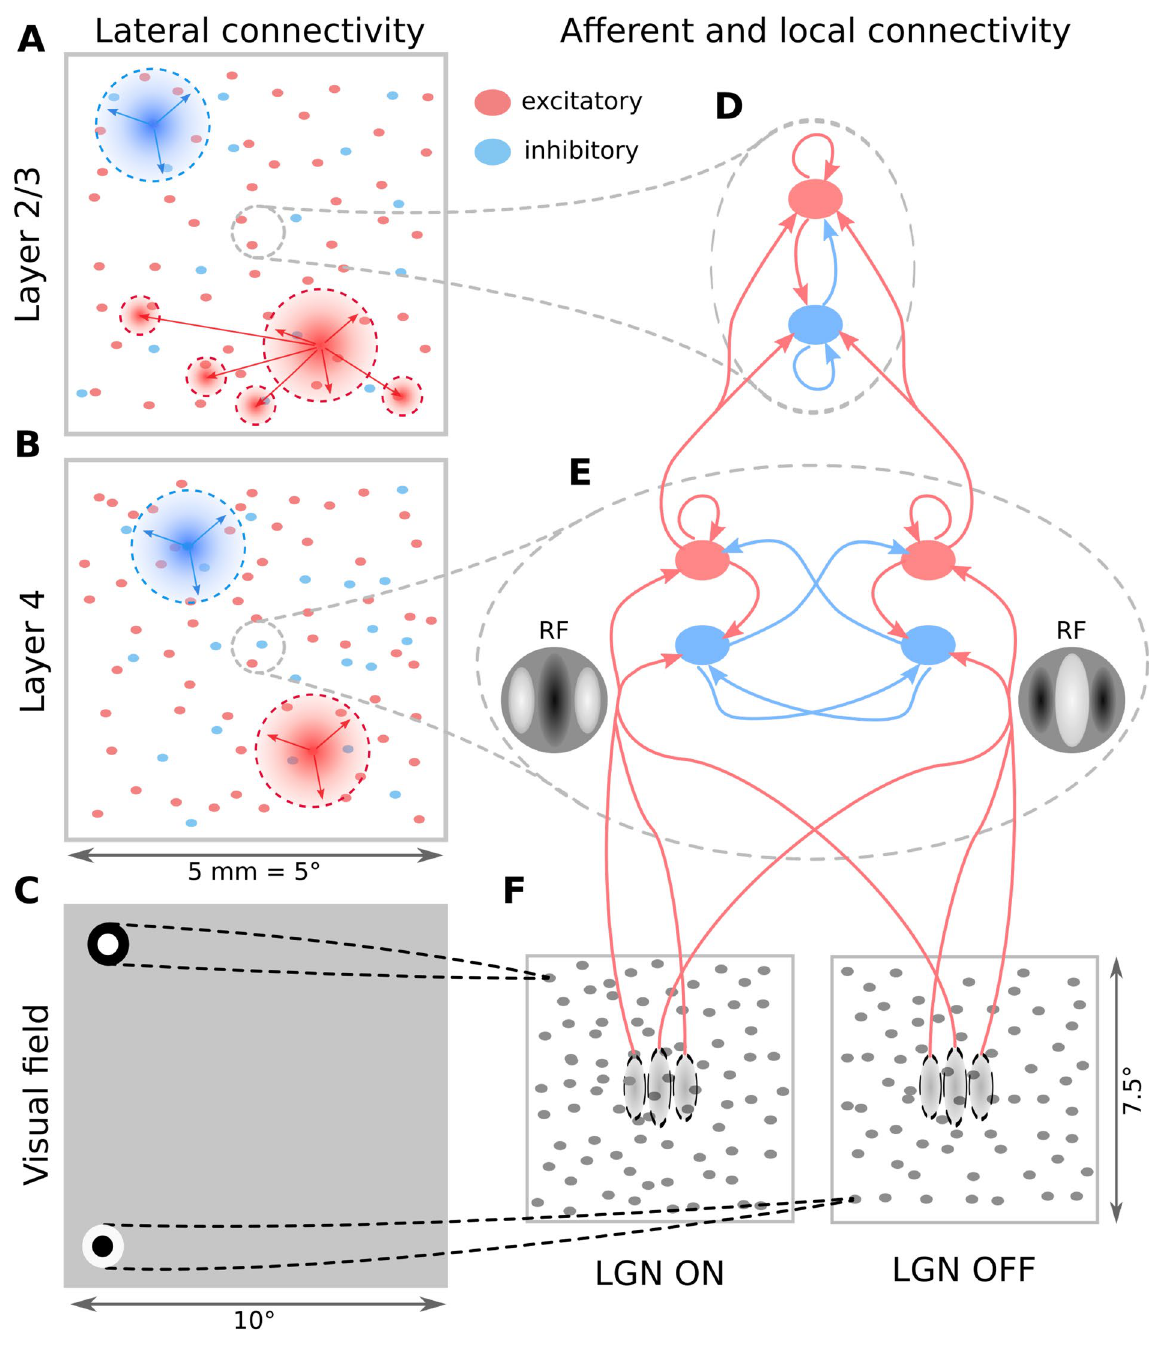
Figure 2. The V1 model architecture. ( A and B ) Layer 2/3 and Layer 4 lateral connectivity. All cortical neurons make local connections within their layer. Layer 2/3 excitatory neurons also make long-range functionally specific connections. For the sake of clarity A and B do not show the functional specificity of local connections and connection ranges are not to scale. ( C ) Extent of the modelled visual field and example of RFs of one ON and one OFF-center LGN relay neuron. As indicated, the model is retinotopically organized. ( D ) Local connectivity scheme in Layer 2/3: connections are orientation- but not phase-specific, leading to predominantly Complex cell type RFs. Both neuron types receive narrow connections from Layer 4 excitatory neurons. ( E ) Local connectivity in Layer 4 follows a push-pull organization. ( F ) Afferent RFs of Layer 4 neurons are formed by sampling synapses from a probability distribution defined by a Gabor function overlaid on the ON and OFF LGN sheets, where positive parts of the Gabor function are overlaid on ON and negative on OFF-center sheets. The ON regions of RFs are shown in white, OFF regions in